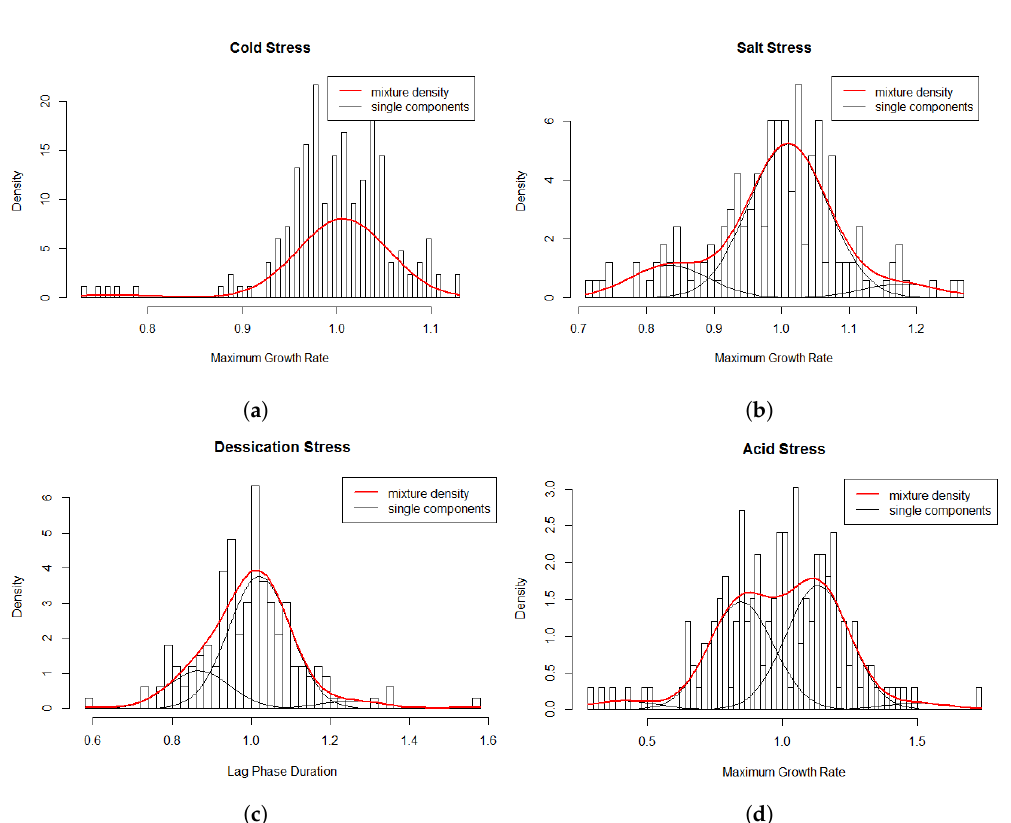
Figure 4. Histogram of relative growth rate parameters and the superimposed mixture model for the